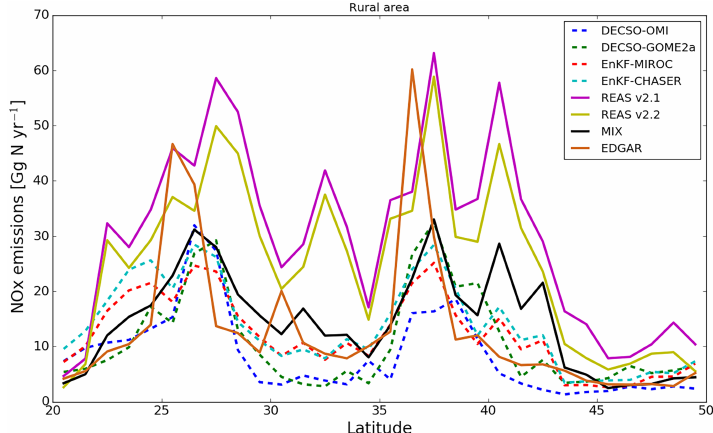
Figure 10. Same as Fig. 9, but for rural grid cells (the blue cells in Fig.